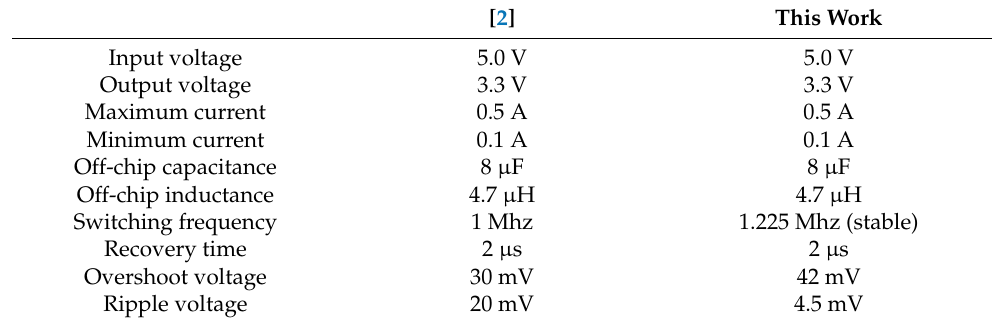
Table 3. Comparison with Hsu’s